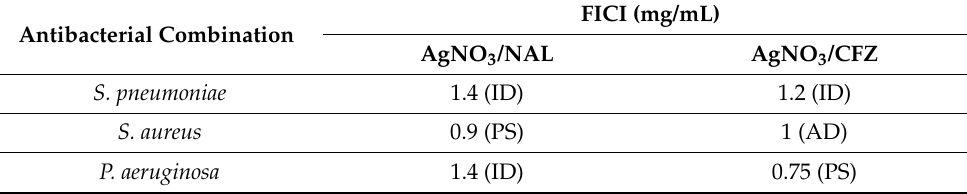
Table 4. Fractional Inhibitory concentration Index of AgNO 3 and antibiotics. SN—synergistic ( ≤ 0.5); PS—partially synergistic (>0.5 to 1); AD—additive (equal to 1); ID—indifferent (>1 to <2); AN—antagonistic ( ≥ 2) on the basis of